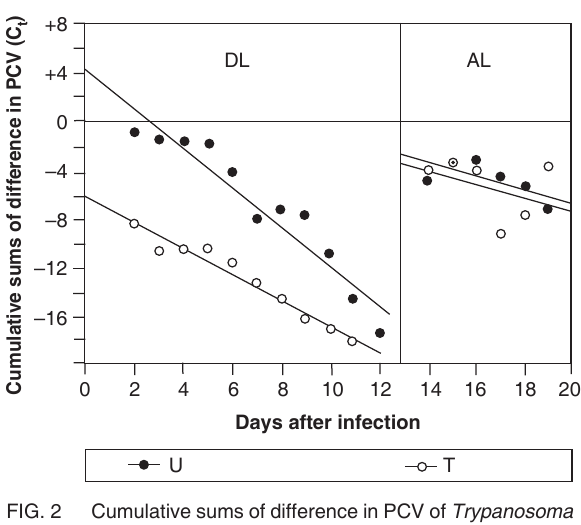
FIG. 2 Cumulative sums of difference in PCV of Trypanosoma vivax -infected Zebu bulls treated (T) and untreated (U) with lactose during (DL) and after (AL) treat